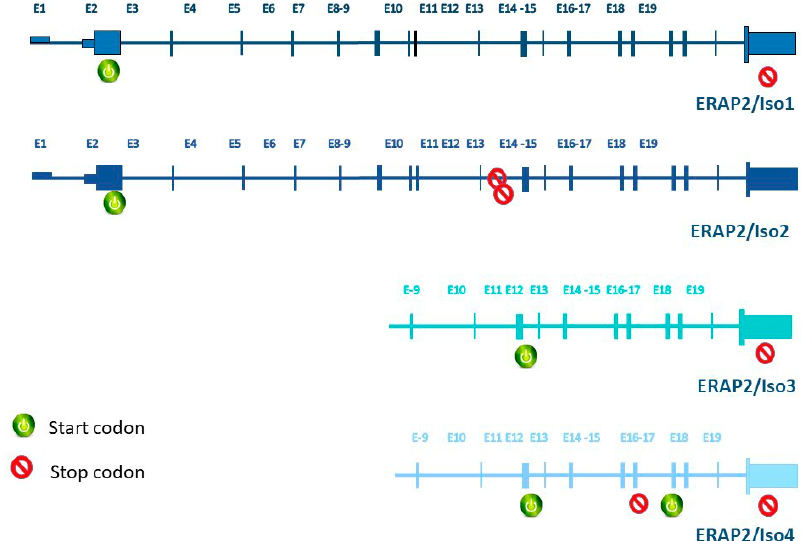
Figure 1. Genetics of ERAP2 isoforms regulation. Structures of transcripts derived from each ERAP2 isoform are represented. Start and stop codons for each isoform are reported.